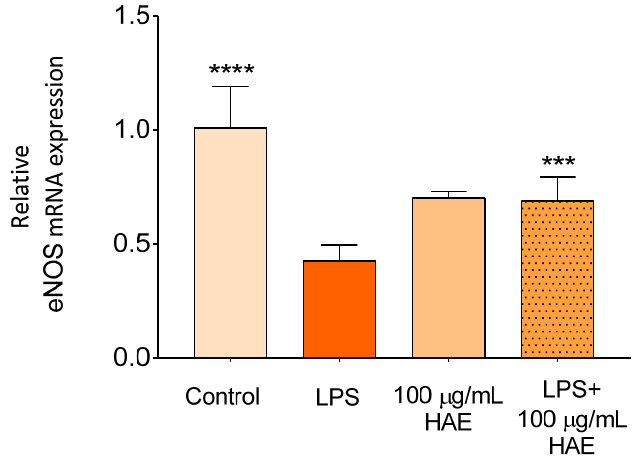
Figure 8. The effect of HAE on expression of eNOS. Total RNA was isolated by using Extrazole. Reverse transcription was performed in a Life ECO Thermal Cycler by using an UltraScript 2.0 cDNA Synthesis Kit. The cDNA was amplified by using the 2 × qPCRBIO Probe Mix No-ROX assay. Data are presented using the ∆∆ CT method regarding glyceraldehyde-3-phosphate dehydrogenase (GAPDH)-normalised mRNA expressions of the untreated control. *** and **** mark significant ( p < 0.0005 and p < 0.0001).